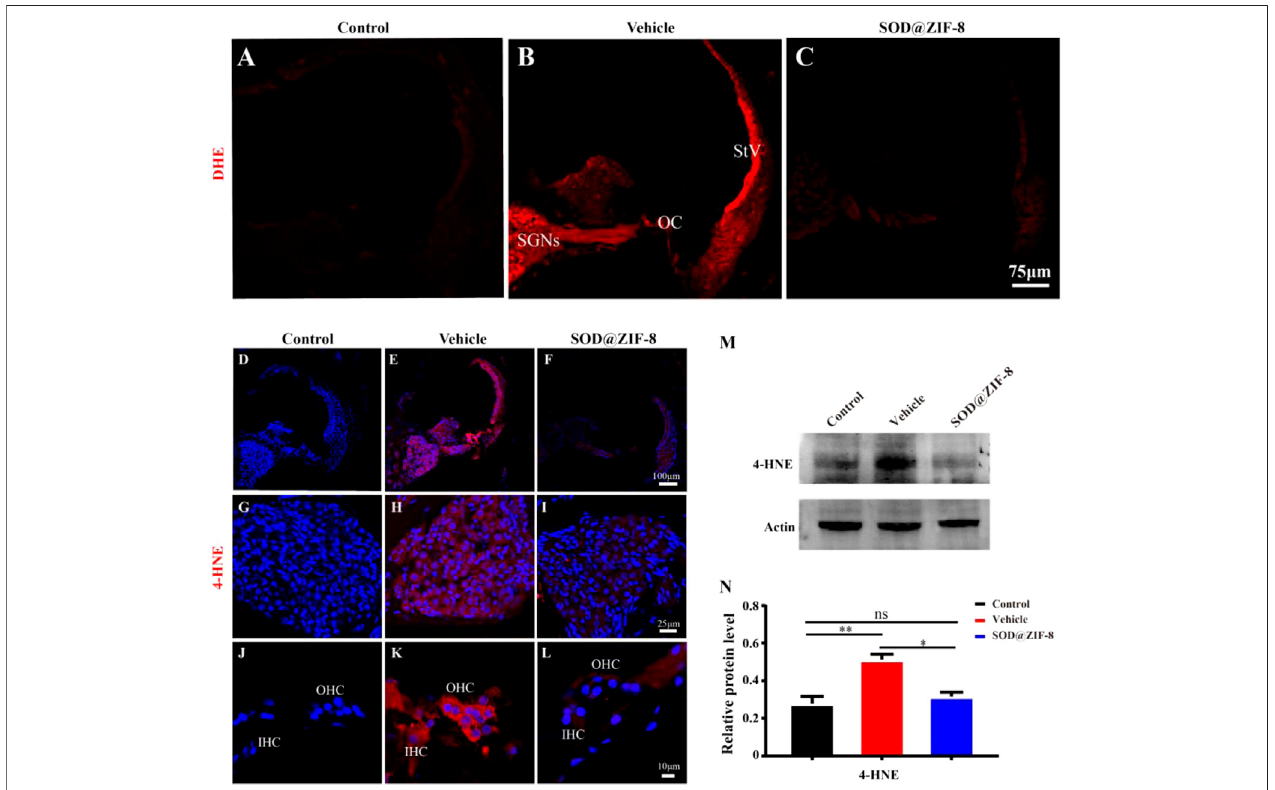
FIGURE 5 | Superoxide dismutase (SOD)@zeolite imidazolate framework-8 (ZIF-8) administration reduced the levels of reactive oxygen species (ROS) and 4- hydroxynonenal (4-HNE) caused by noise. (A – C) Representative images of dihydroethidium staining in the middle – basal cochlear turns from three groups. (D – F) Representative images of 4-HNE staining in the middle – basal cochlear turns from three groups. 4-HNE fl uorescence obviously changed in the spiral ganglion neurons (SGNs) (G – I) and organ of Corti (OC) (J – L) . (M,N) Protein expression level and statistical analysis of 4-HNE in the cochleae of various groups (StV: Stria Vascularis; OC: Organ of Corti; SGNs: Spiral Ganglion Neurons). Data (N) are presented as means ± standard deviation (SD) (* p < 0.05, ** p < 0.01, ns: no statistical signi fi cance).